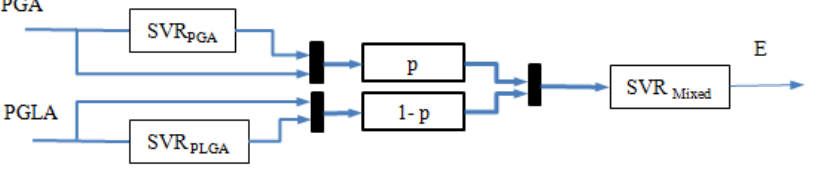
Figure 3. HSVRM block diagram.